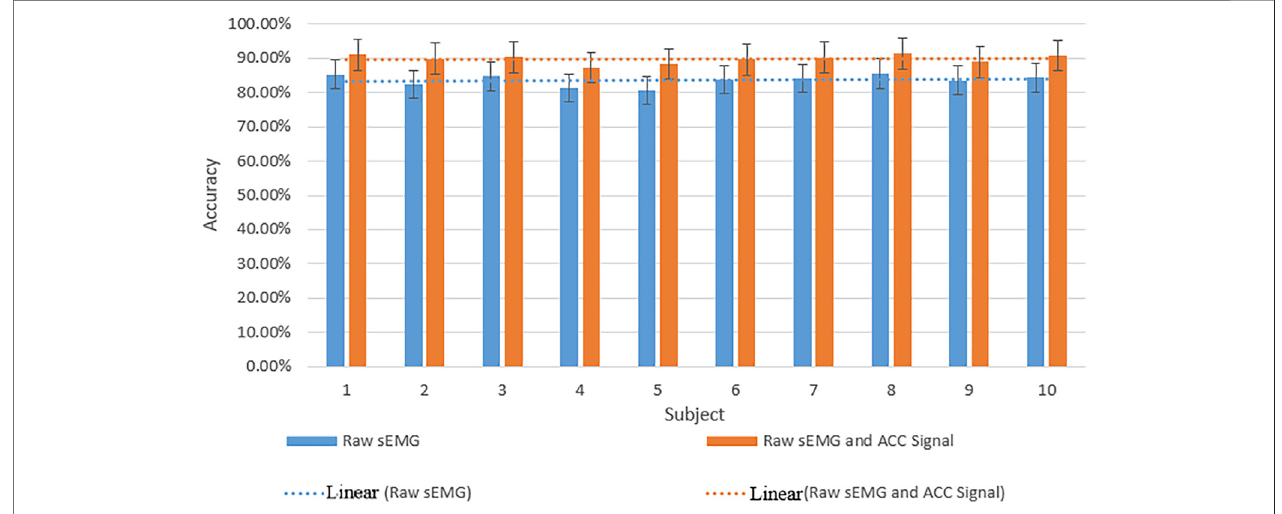
FIGURE 11 | The recognition rate of 10 subjects on